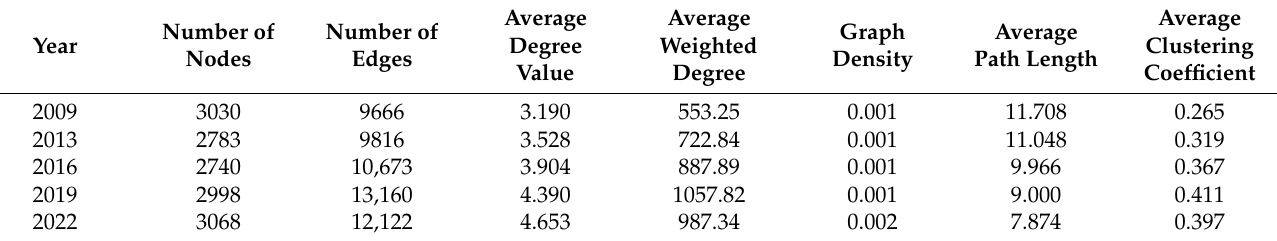
Table 2. Railway network structure characteristics